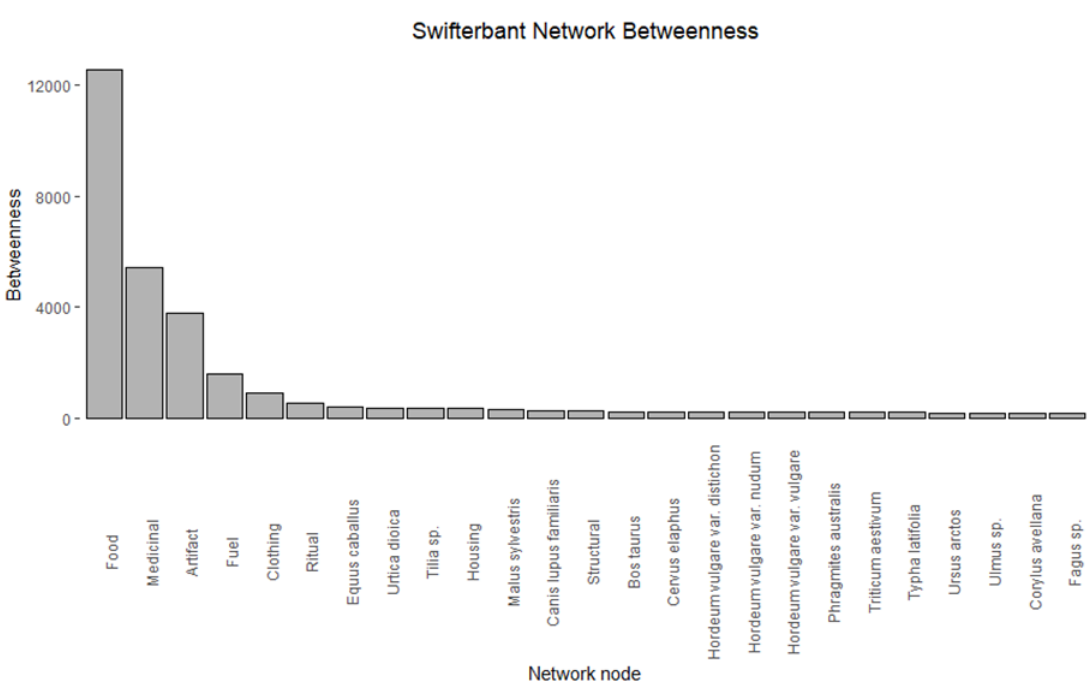
Figure 3. Network degree (top 25).